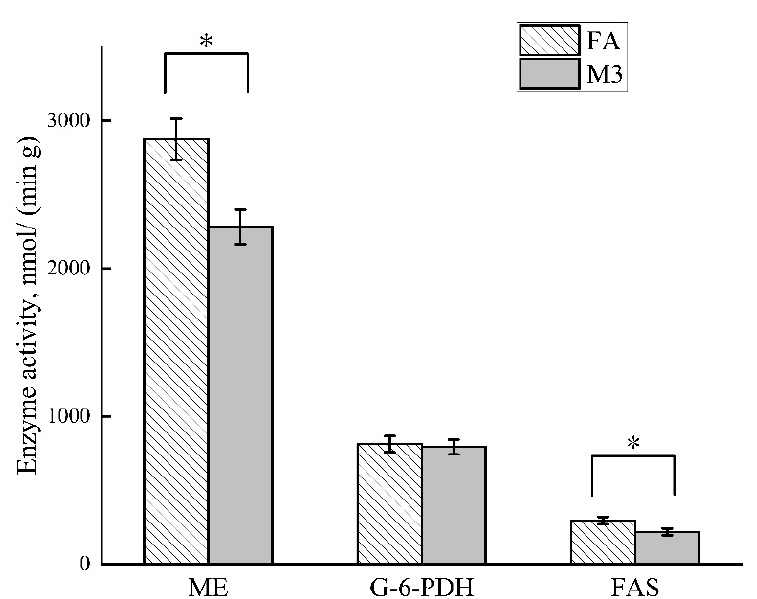
Figure 1. ( a ) Effects of feeding frequency on adipose tissue lipid content; ( b ) Effects of feeding fre- quency on fat cell diameter. FA, pigs had free access to feed; M3, pigs were given three meals per day (06:00, 14:00, and 22:00 h).